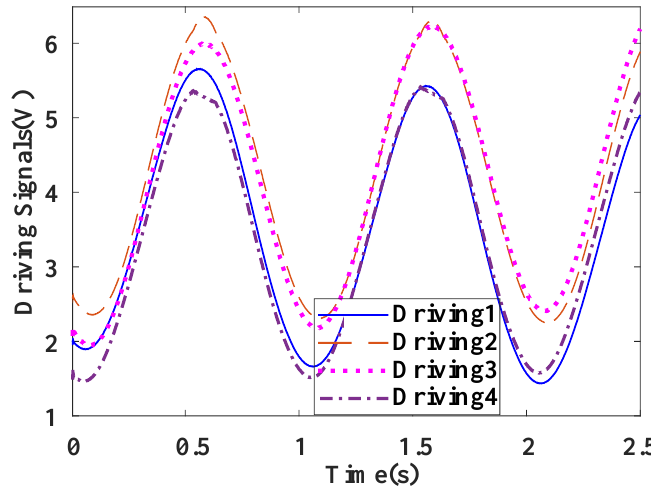
Figure 11. Voltage signals of four actuators under PID control.